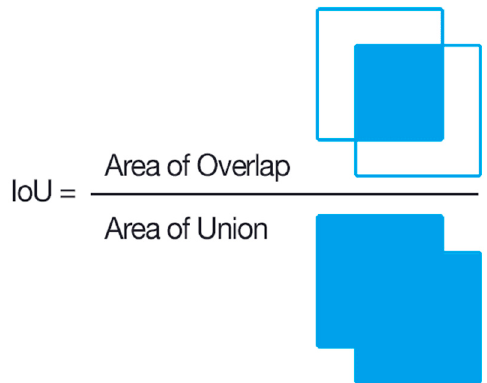
Figure 5. IoU calculation